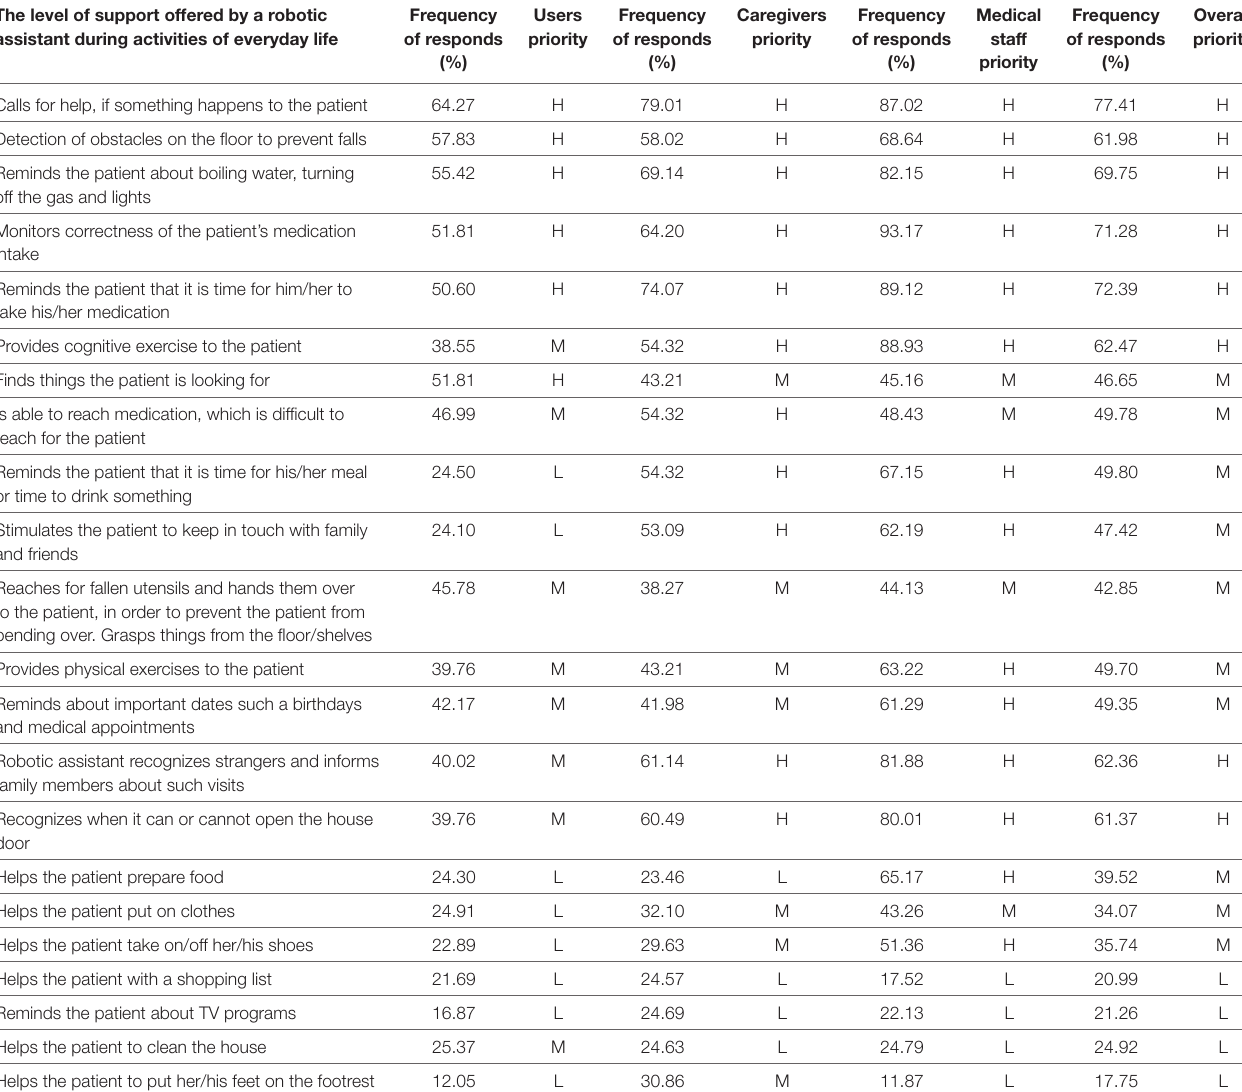
Table 3 | Prioritization of functional requirements.